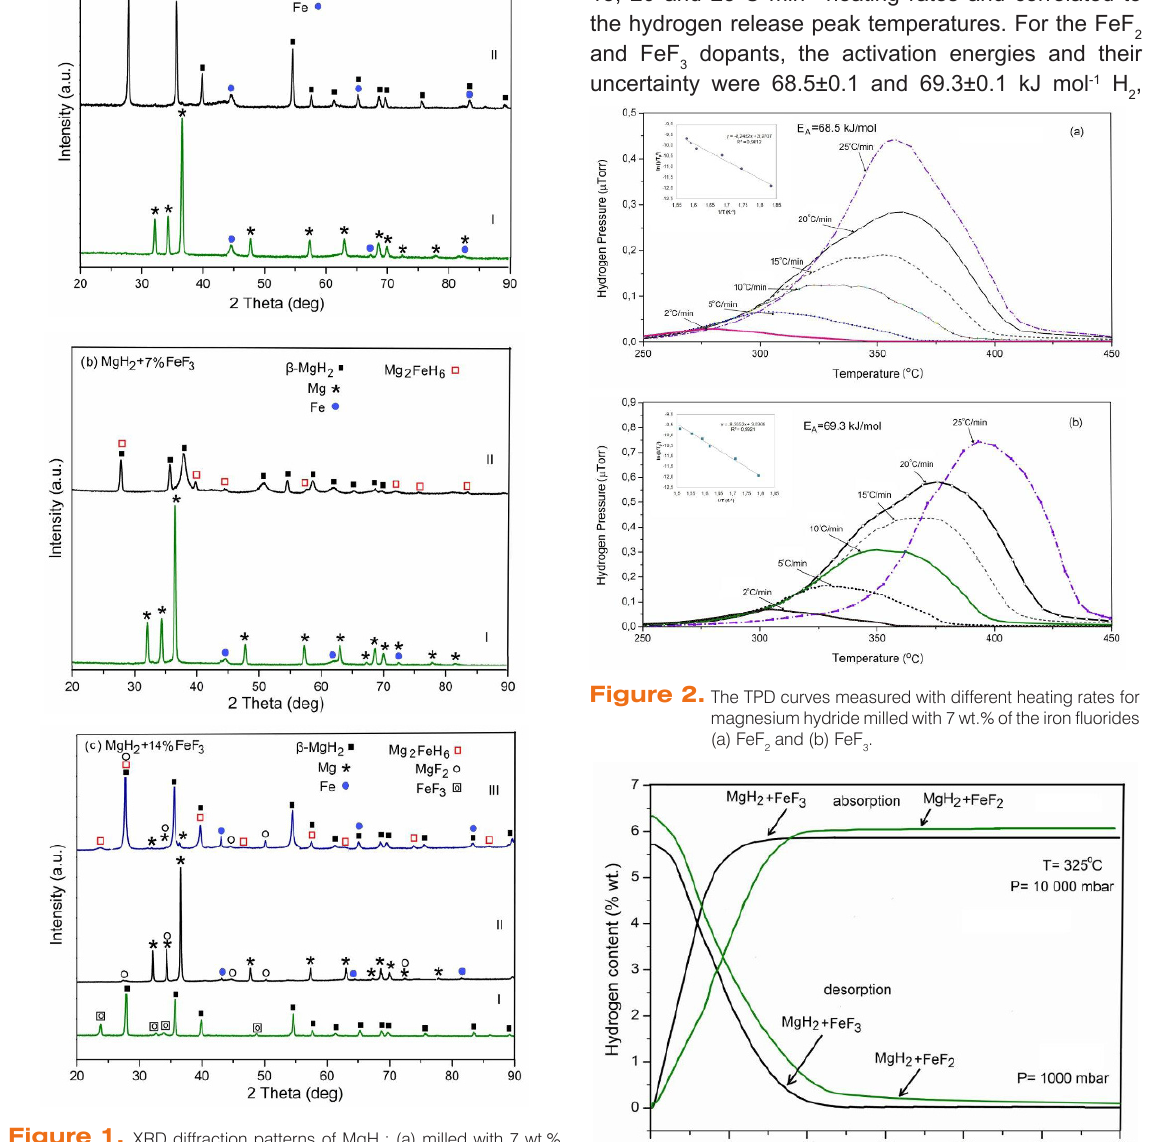
: (a) milled with 7 wt.% 2